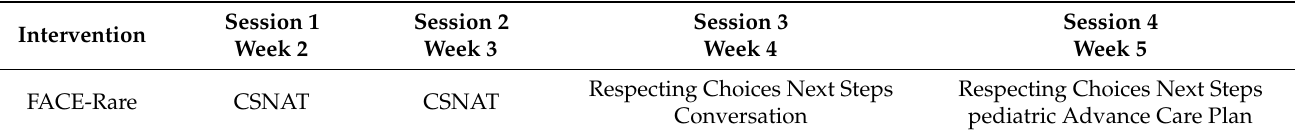
Table 1. FACE-Rare Study Protocol